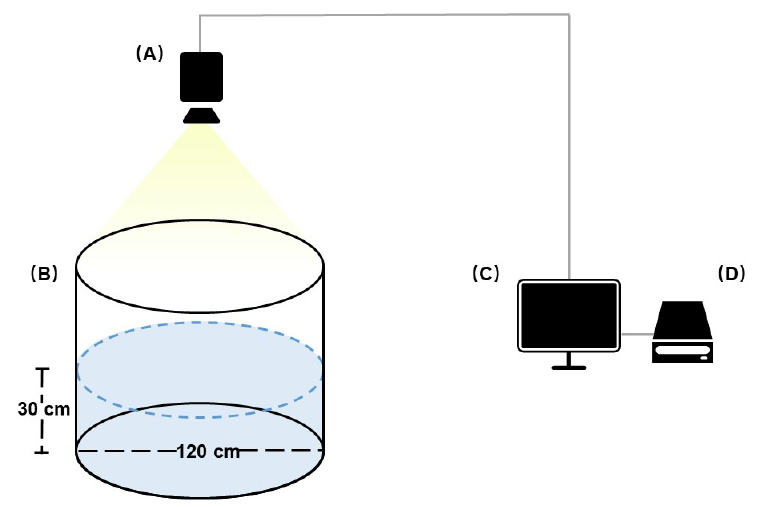
Figure 1. Animal behavioral capture system: infrared camera (A), experimental aquarium (B), monitor (C), and video recorder